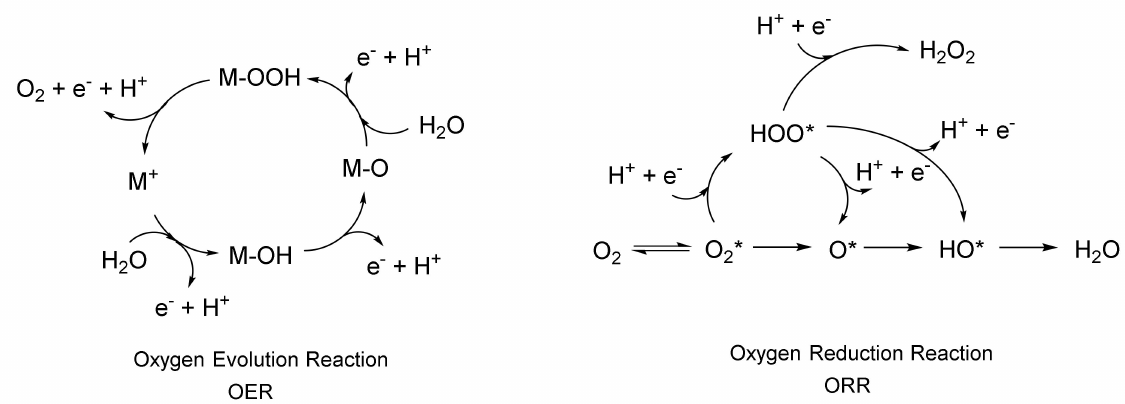
Figure 5. Example of a typical oxygen evolution reaction (OER) and oxygen reduction reaction